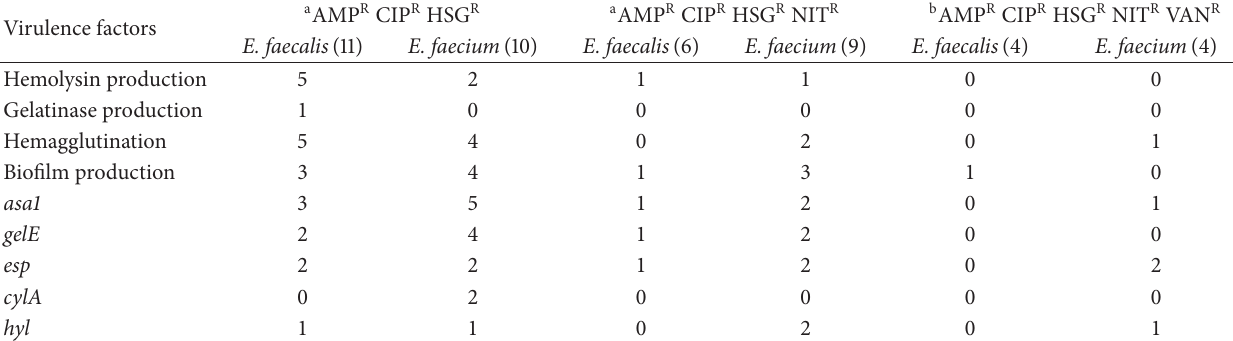
Table 4: Relation of antimicrobial resistance with virulence in